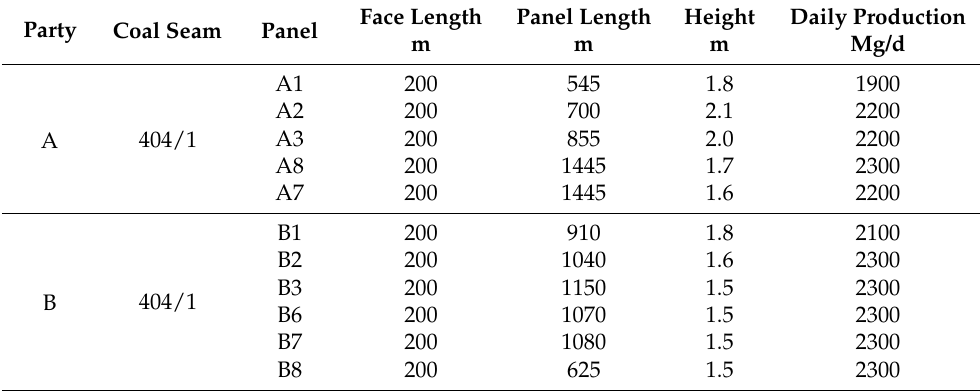
Table 3. Parameters of longwall panels in parties A and B of 404/1 coal seam.